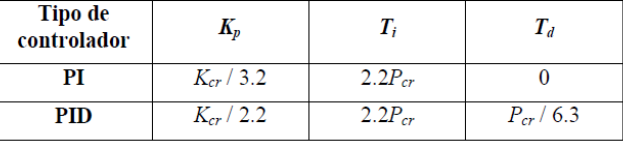
Tabla 3: Reglas de sintonización Tyreus-Luyben.